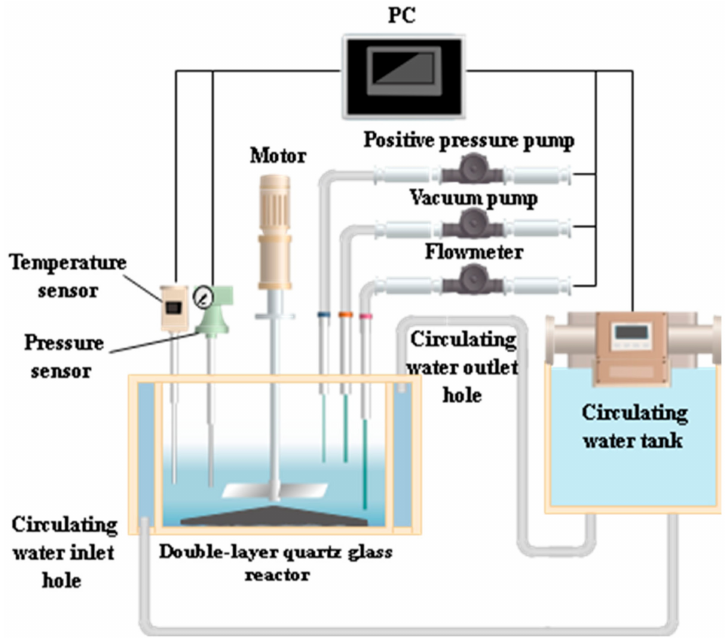
Figure 2. Automated hydrogen